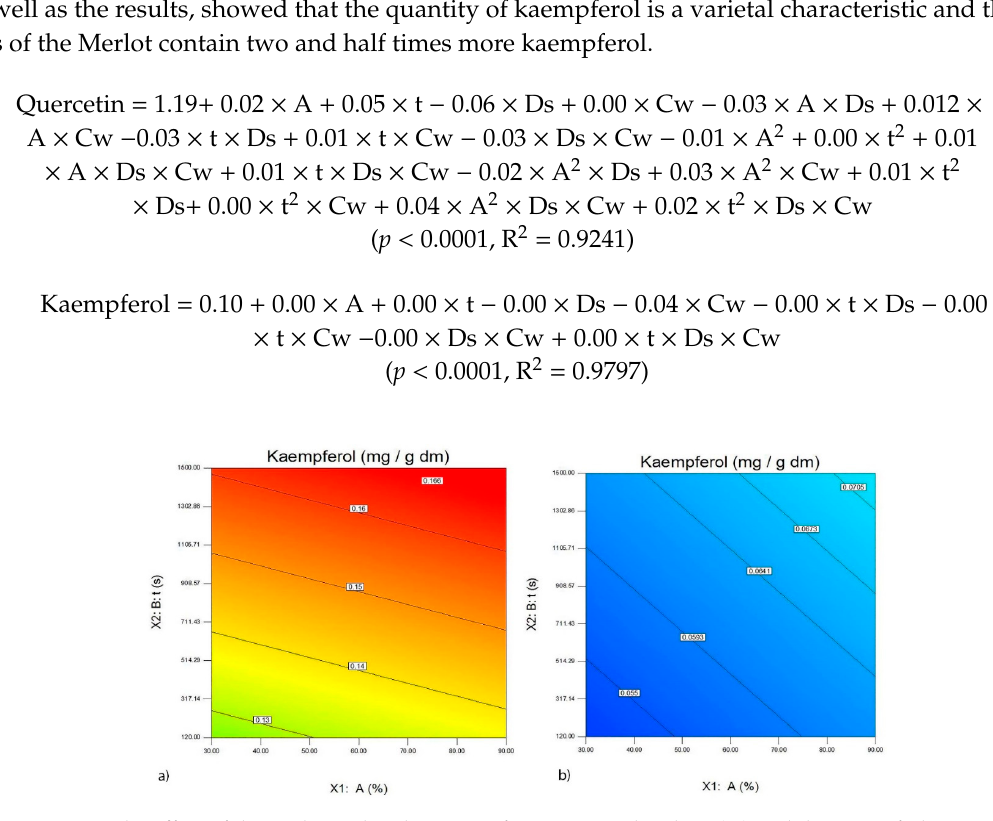
Figure 5. The effect of the probe with a diameter of 22 mm, amplitude A (%) and the time of ultrasound extraction t (s) on the quantity of Mv-3-glucoside (mg/g d.m.) in the extracts of the wine lees of the Merlot variety ( a ) and the wine lees of the Vranac variety ( b ).